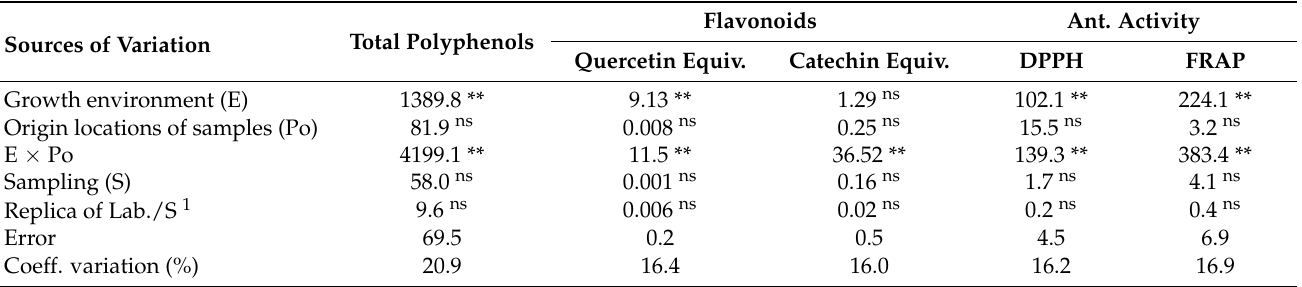
Table 2. Significance of square means of the analysis of variance of phenolic compounds and antioxidant activity of A. petiolaris from Oaxaca, Mexico.